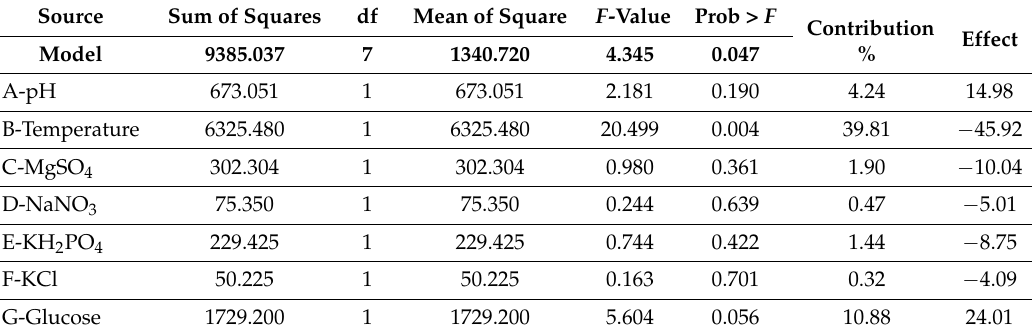
Table 3. Determination of significant variables for production of protease by the endophytic fungus Penicillium bilaiae using Plackett-Burman